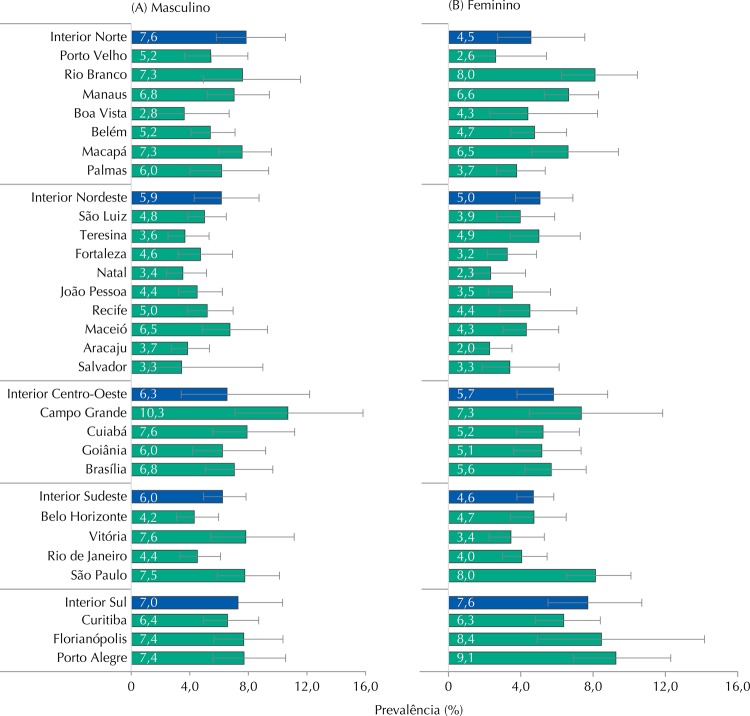
Prevalências (%) e IC95% de tabagismo em adolescentes do sexo masculino (A) e feminino (B) por capitais e estratos de municípios com mais de 100 mil habitantes do interior das regiões. ERICA, Brasil, 2013-2014.